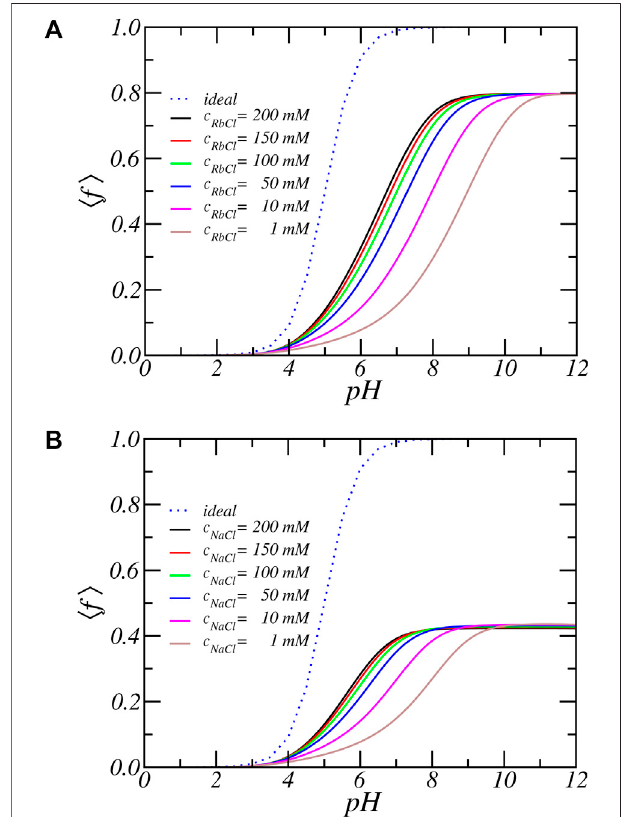
FIGURE 2 | The average degree of dissociation as function of reservoir pH for increasing (A) RbCl and (B) NaCl salt concentrations. The line labeled ‘ ideal ’ represent the ideal solution